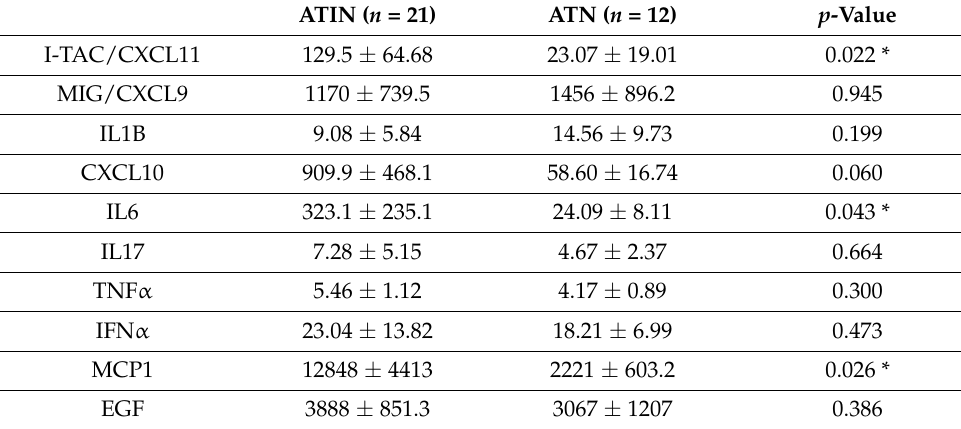
Table 4. Comparison of the urinary concentration of the evaluated cytokines in patients with ATIN and ATN. * Statistically significant differences. ATIN—acute tubulointerstitial nephirits, ATN—acute tubular necrosis.